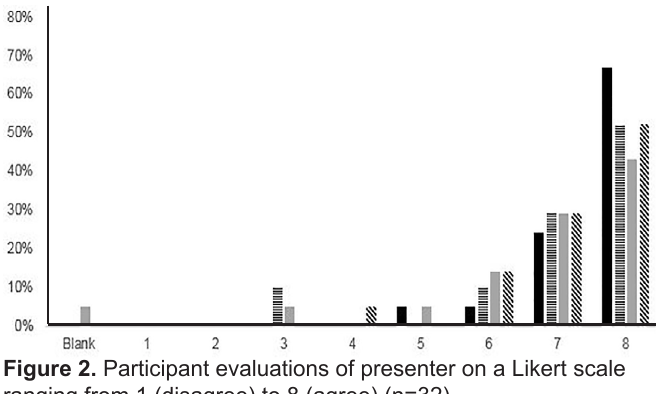
Figure 2. Participant evaluations of presenter on a Likert scale ranging from 1 (disagree) to 8 (agree)